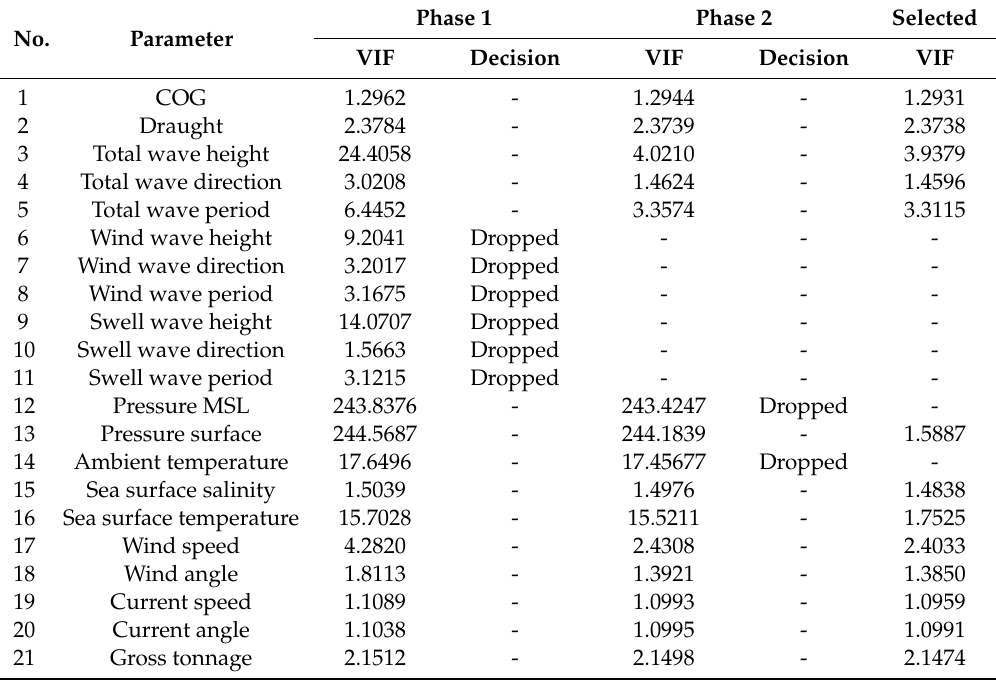
Table 7. VIF analysis